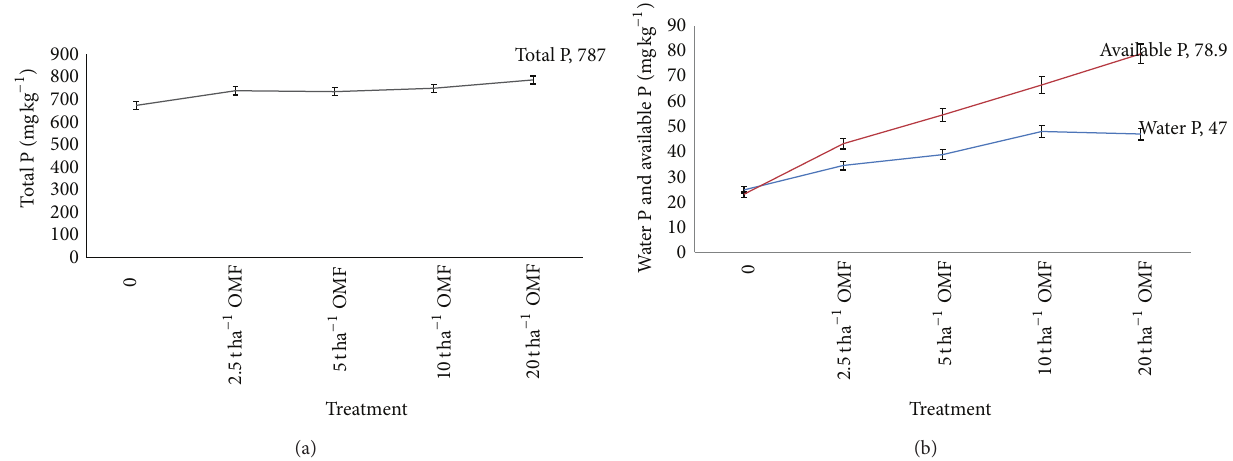
Figure 2: (a) Effect of organomineral fertilizer on total P. Lsd (0.05) = 11. (b) Effect of organomineral fertilizer on water P and available P. Lsd (0.05) water P = 6.03, avail. P = 8.07.